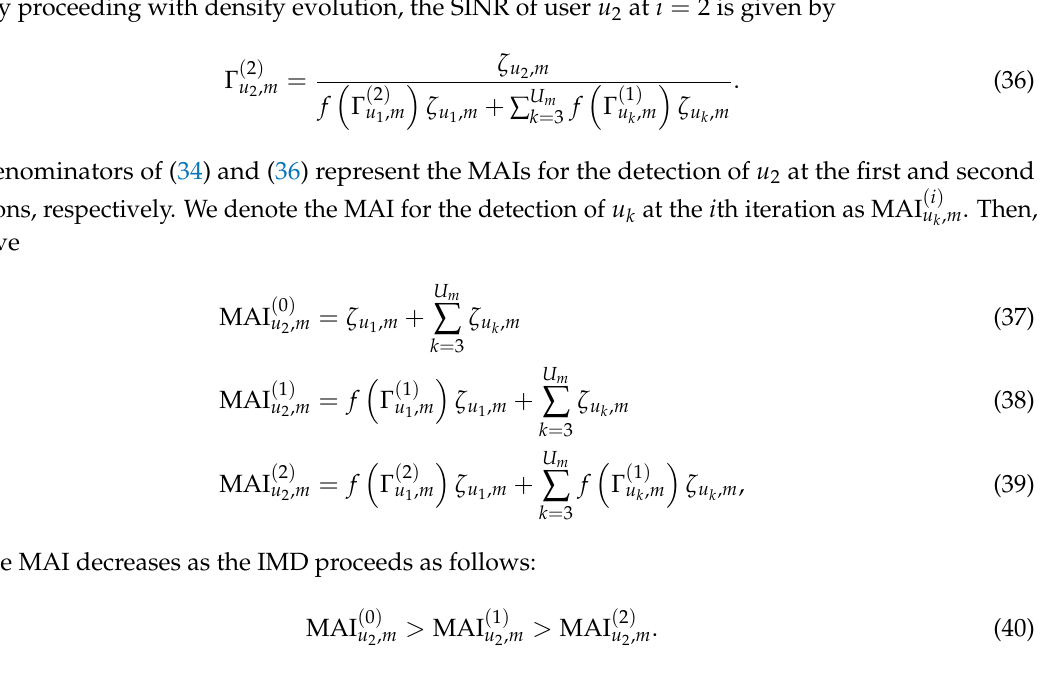
Figure 3. Frequency domain variance f ( SINR ) versus